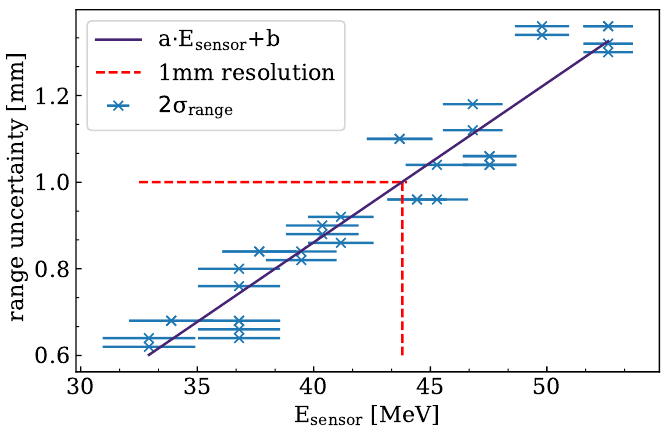
Figure 14. Uncertainty of the measured proton range in water as a function of the expected incident proton energy E sensor ( a = ( 0.037 ± 0.002 ) mm , b = ( − 0.60 ± 0.08 ) mm). The upper energy limit MeV E max. = ( 43.8 ± 3.2 ) MeV to fulfill the QA requirement is